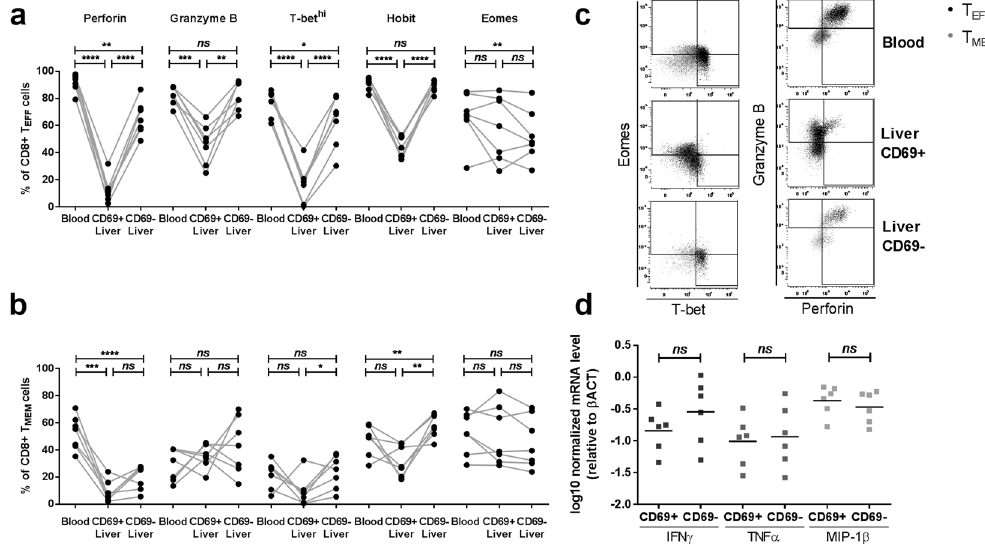
Figure 4. Frequency of perforin + , granzyme B + , Tbet hi , Hobit + and Eomes + cells as a percentage of CD8 + T EFF ( a ) and T MEM ( b ) in control blood and liver (CD69 + and CD69 − ). Statistical analyses; paired t-test. ( c ) Representative FACS staining and gating for perforin, granzyme B, Eomes and T-bet in blood and liver CD69 + ad CD69- T EFF and T MEM cells. Statistical analyses; paired t-test. ( d ) Relative expression of cytokines interferon- γ (IFN γ ), tumor necrosis factor- α (TNF α ) and macrophage inflammatory protein 1 β (MIP-1 β ) in sorted CD69 + and CD69-CD8 + T cells from control livers. Bars indicate median. Statistical analyses; Wilcoxon signed rank test. * p < 0.05, ** p < 0.01, *** p < 0.001 **** p < 0.0001. Abbreviations: ns,